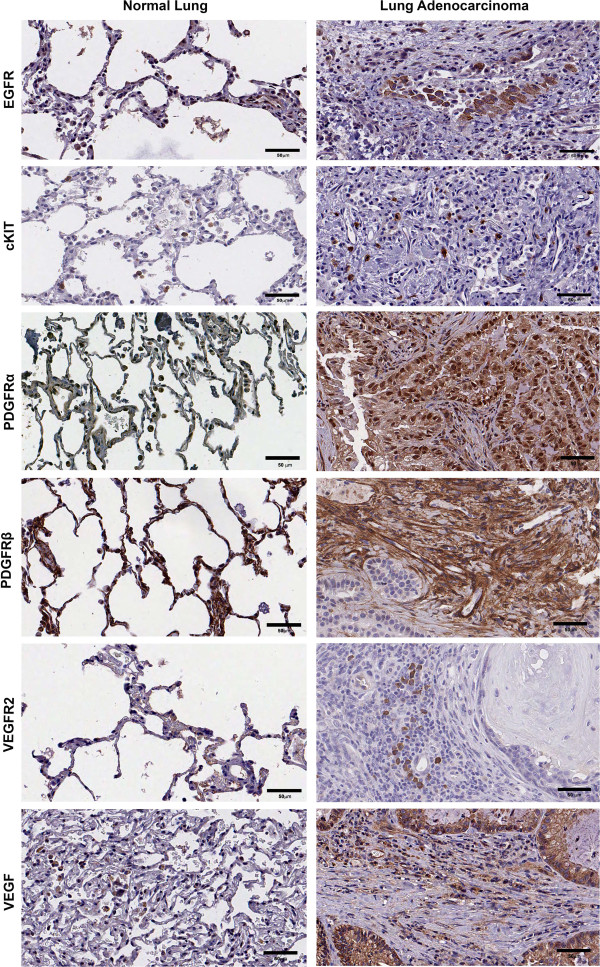
Representative micrographs of immunohistochemistry for selected TKRs and VEGF expression in TMA cores of normal lung and cpAC samples. The tissues were probed with the antibodies for EGFR, cKIT, PDGFRα, PDGFRβ, VEGFR2 and VEGF proteins. Left set of panels: Representative images of positive immunoreactivity for the TKRs and growth factor as shown by the brown staining in normal lung. Right set of panels: Representative images of positive immunoreactivity for the TKRs and growth factor as shown by the brown staining in neoplastic cells and/or stroma of the adenocarcinoma tissue. x 40; bar 50 μm.